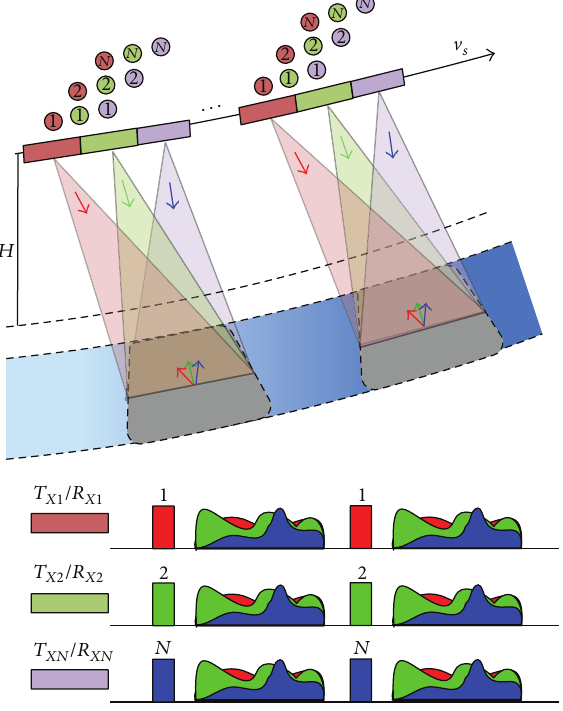
Figure 1: Schematic diagram of the MIMO SAR using STFC.